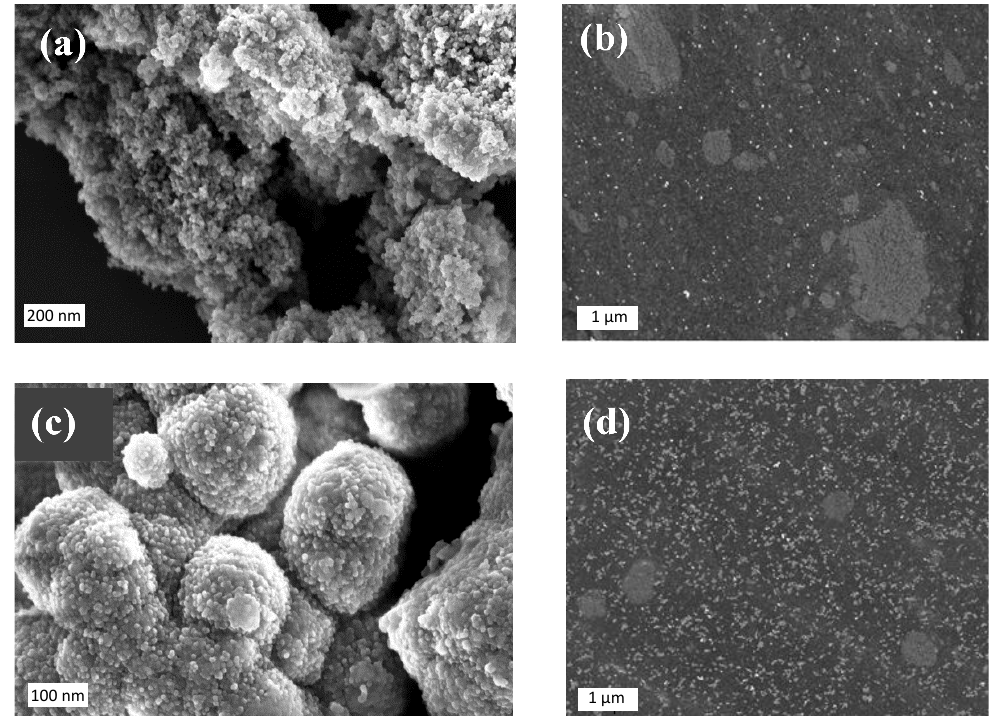
Figure 4. SEM images of ( a ) pristine commercial precipitated silica powder, and ( b ) its respective SSBR composite. ( c ) In-situ silica powder (extracted from un-crosslinked rubber) and ( d ) its respective SSBR composite.